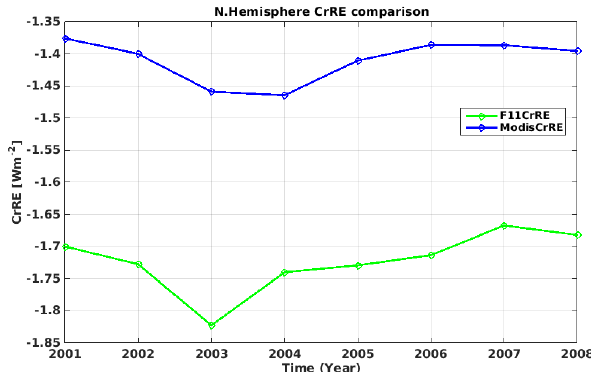
Figure 10. Annual-mean northern hemispheric LCrRE time se- ries derived for the current study (ModisCrRE) and by Flanner et al. (2011) (F11CrRE) using CAM3